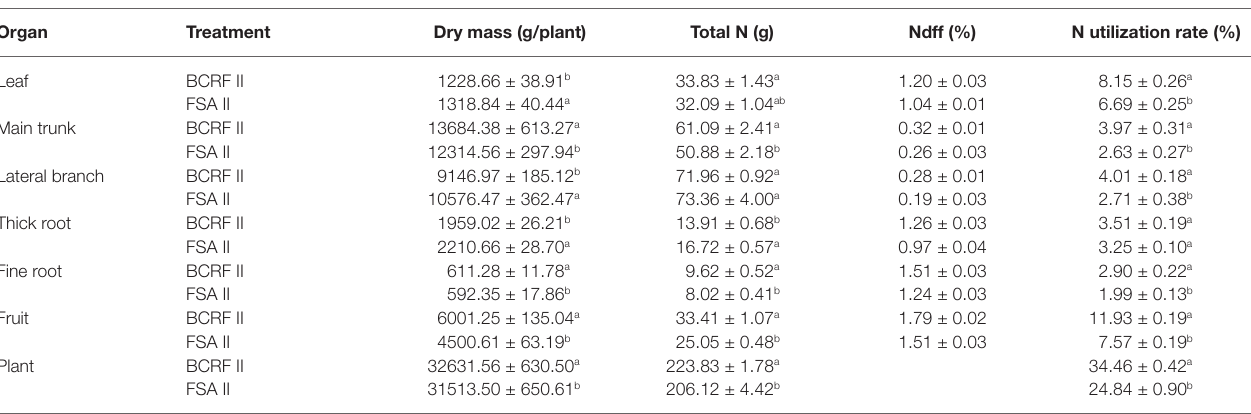
TABLE 5 | Effects of different fertilization modes on the nitrogen utilization